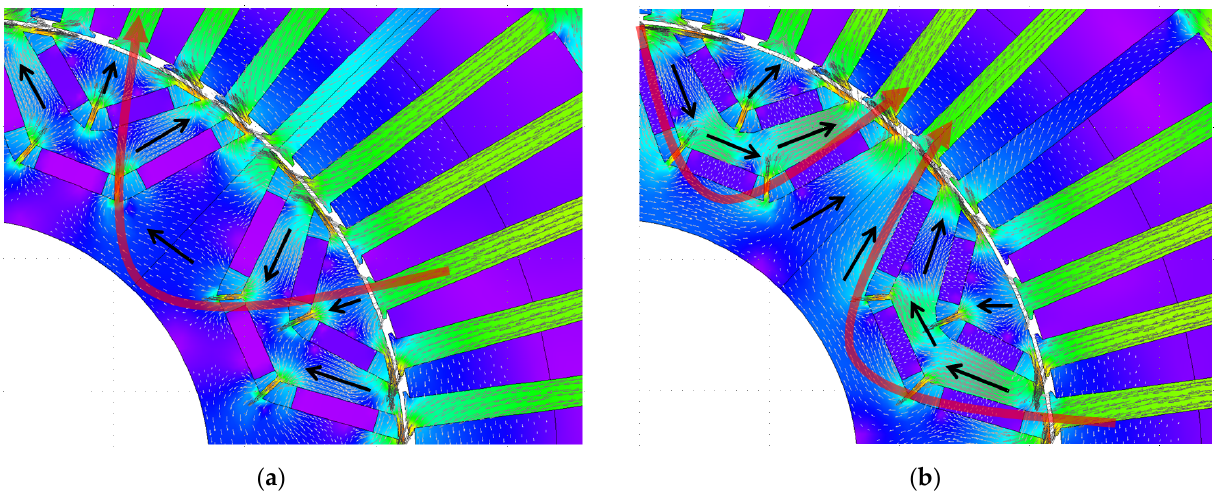
Figure 7. Magnetic flux density contour and vector plots for the VU-shape machine with 2 different q -axis current values in addition to -5 pu d -axis current: ( a ) i q = 0 pu; ( b ) i q = 2 pu.